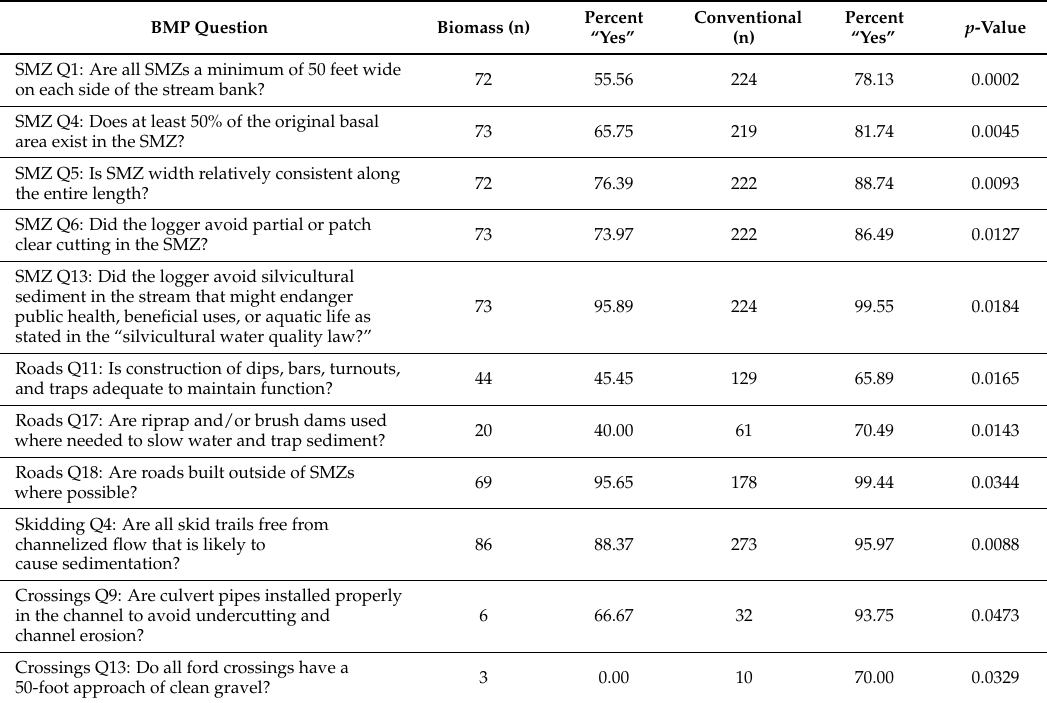
Table 4. The Virginia Department of Forestry (VDOF) BMP audit questions with significant differences at the α < 0.05 level between biomass and conventional